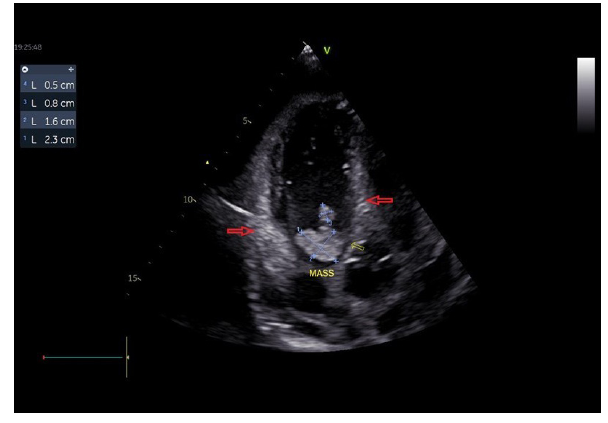
Figure 2. Echocardiography showed the presence of a mass in the right atrium and septal leaflet of tricuspid (yellow arrow). Hyperechoic areas were found in the annulus of tricuspid, lateral wall of right atrium and right ventricle, and interventricular septum (red arrows).